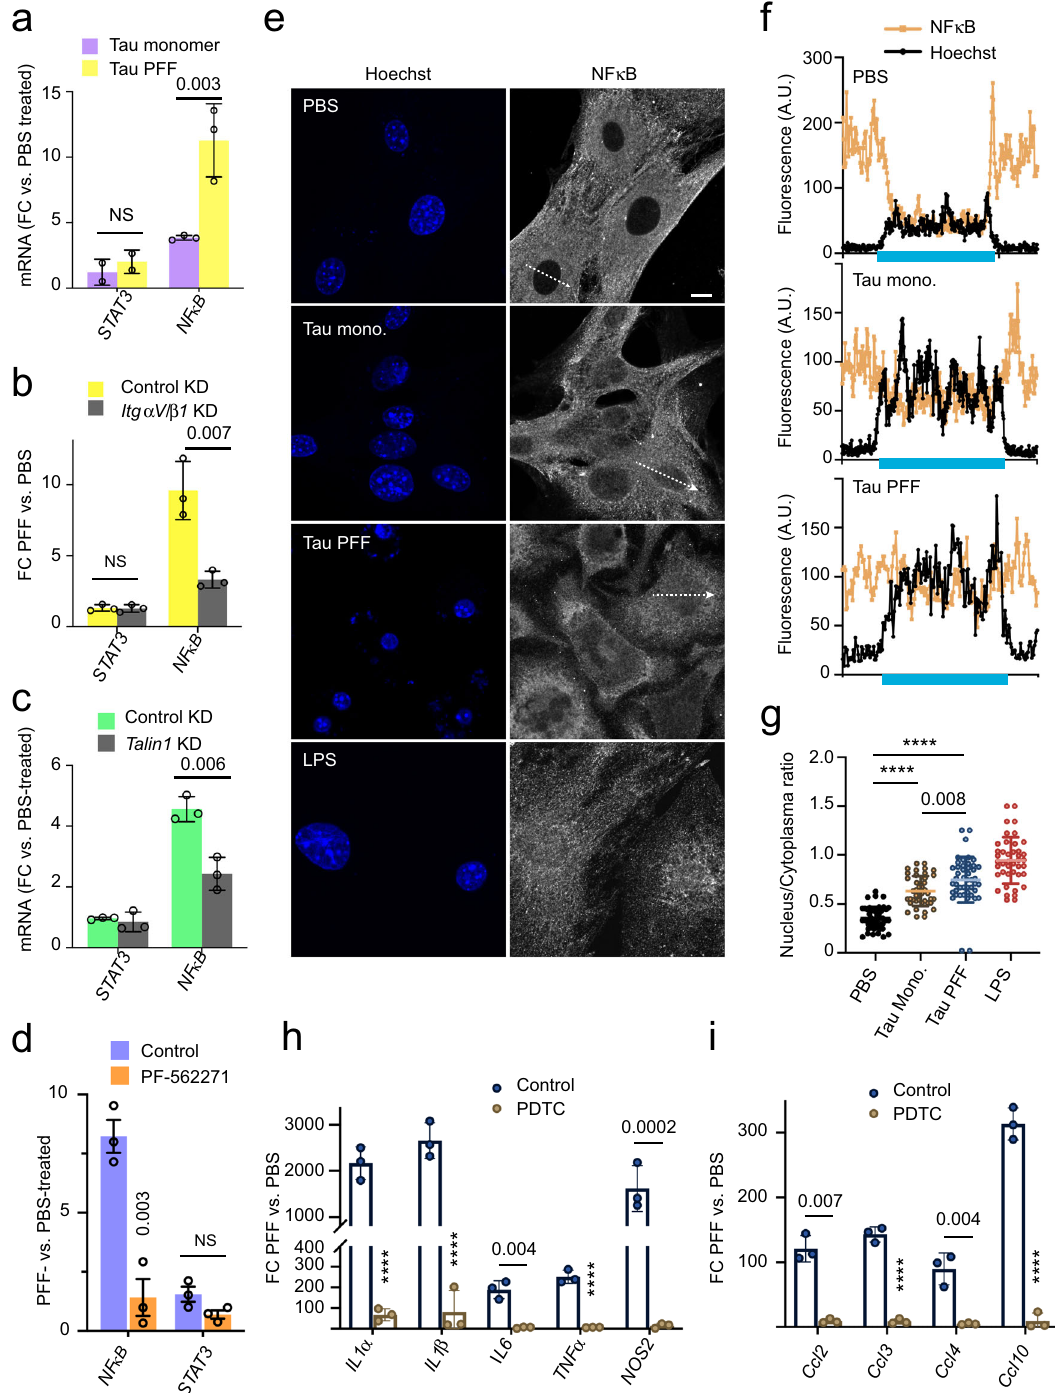
Fig. 5 Tau PFF-induced in fl ammation is dependent on NF κ B activation. a qRT-PCR analyses of the expression of NF κ B and STAT3 in primary astrocytes exposed to PBS, monomeric Tau or Tau PFFs (200 nM) for 6 h. Shown are fold changes (FC) normalized to PBS-treated cells. Mean ± SEM, n = 3 independent experiments each with two technical repeats. b , c As in a , except that cells were fi rst infected with control or ITG α V/ β 1 shRNA ( b ), or Talin1 shRNA ( c ) for 72 h and then incubated with PBS or Tau PFFs (200 nM) for 6 h. Mean ± SEM, n = 3 independent experiments. d As in b , except that control-treated or PF-562271-treated astrocytes were used. Mean ± SEM, n = 3 independent experiments. e – g Tau PFF increases NF κ B nuclear translocation. e Representative confocal images of astrocytes treated with either PBS, Tau monomer, PFFs (200 nM) for 4 h or LPS as a positive control (5 μ M) for 30 min. Cell were fi xed and stained with a NF κ B antibody and Hoechst (blue). The graphs in f show the fl uorescence intensity pro fi le along the lines indicated in e . The blue bars indicate nuclear regions. g Quanti fi cation of the nuclear/cytoplasmic NF κ B ratio in randomly selected cells. Mean ± SEM, n = 3 biologically independent experiments. h , i Tau PFF-induced in fl ammation is suppressed by a NF κ B inhibitor. As in d , except that cells were pre-treated with PDTC (90 μ M) for 1 h before Tau PFF and PBS treatment and that the indicated genes were analyzed. Mean ± SEM, n = 3 independent experiments. The numbers and asterisks above indicate p value (**** p < 0.0001) determined by two-tailed unpaired t